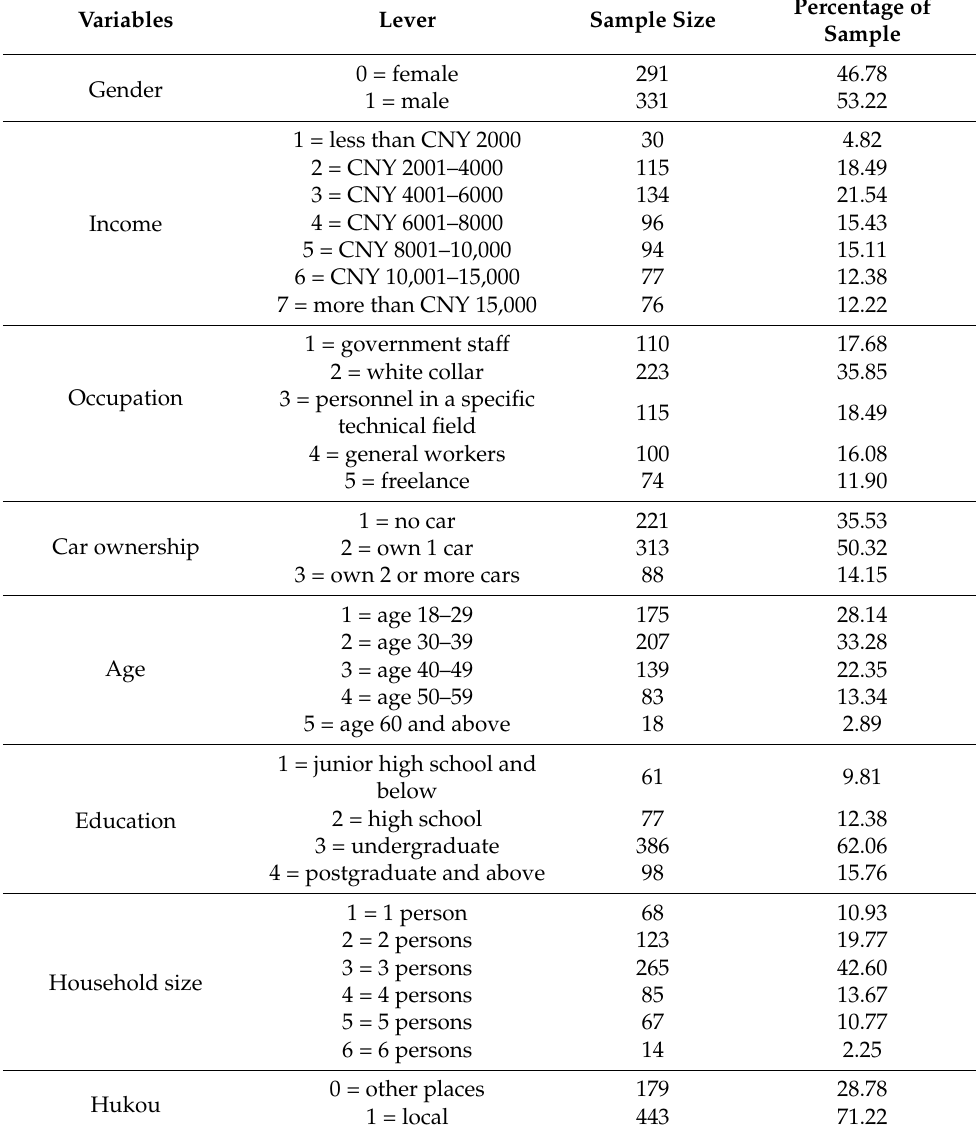
Table 7. Socio-demographic characteristics of the